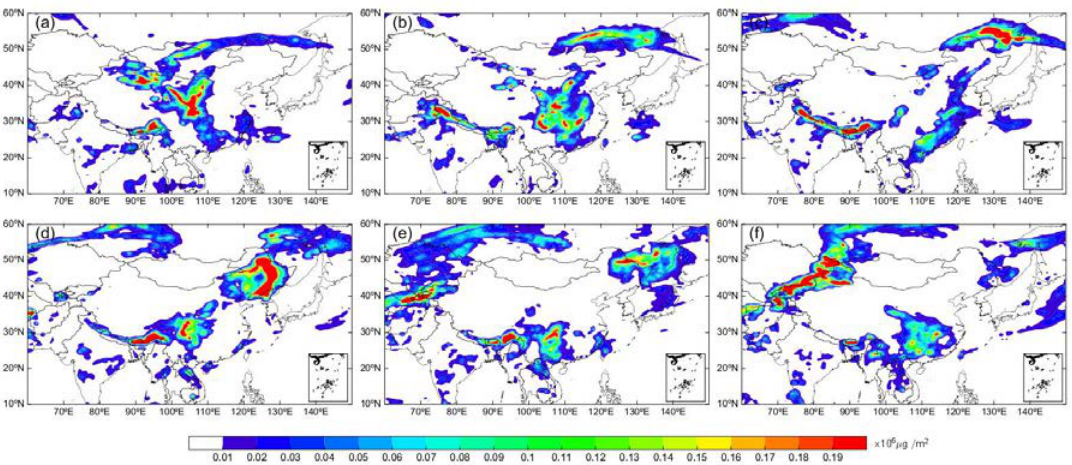
Figure 14. Spatial distribution of daily dust aerosol wet deposition on 2–7 May 2017(sub-graph (a) to (f) respectively describe dust aerosol wet deposition on 2–7 May 2017).